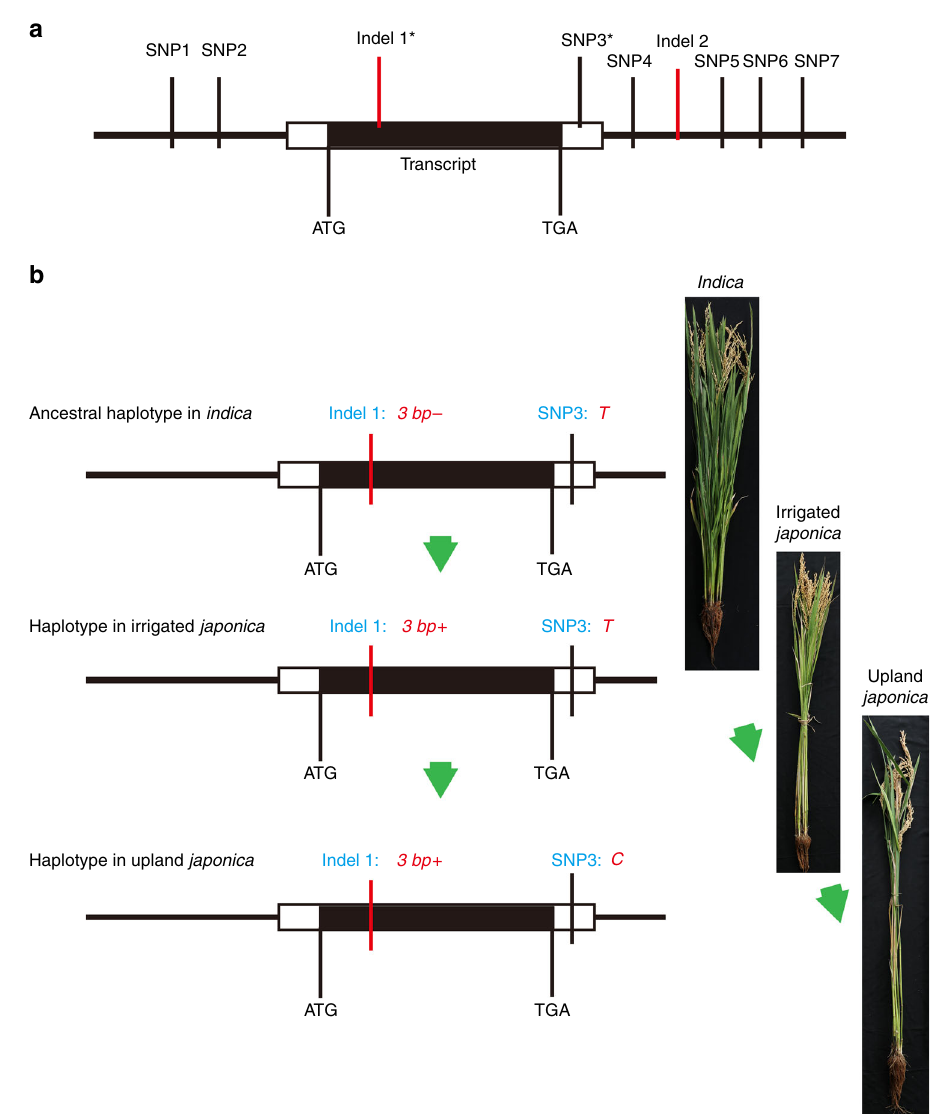
Fig. 2 Variants and haplotypes of OsTb2 . a Structure and polymorphic sites of OsTb2 . Two indels and seven SNPs were found in the OsTb2 gene. Indel I and SNP3 (bold with asterisk) are both signi fi cantly associated with tiller numbers. b Indel I and/or SNP3 in the OsTb2 gene may be functional variants for which three haplotypes were observed in the germplasm. The 3bp-/T haplotype is present in indica and wild rice, and thus likely to be the ancestral haplotype. The 3bp + /T haplotype is mainly found in irrigated japonica , and the 3bp + /C haplotype is speci fi c to upland japonica , consistent with the evolutionary viewpoint that upland japonica evolved from irrigated japonica . Table 1 Association between OsTb2 polymorphic sites and tiller numbers. Polymorphic